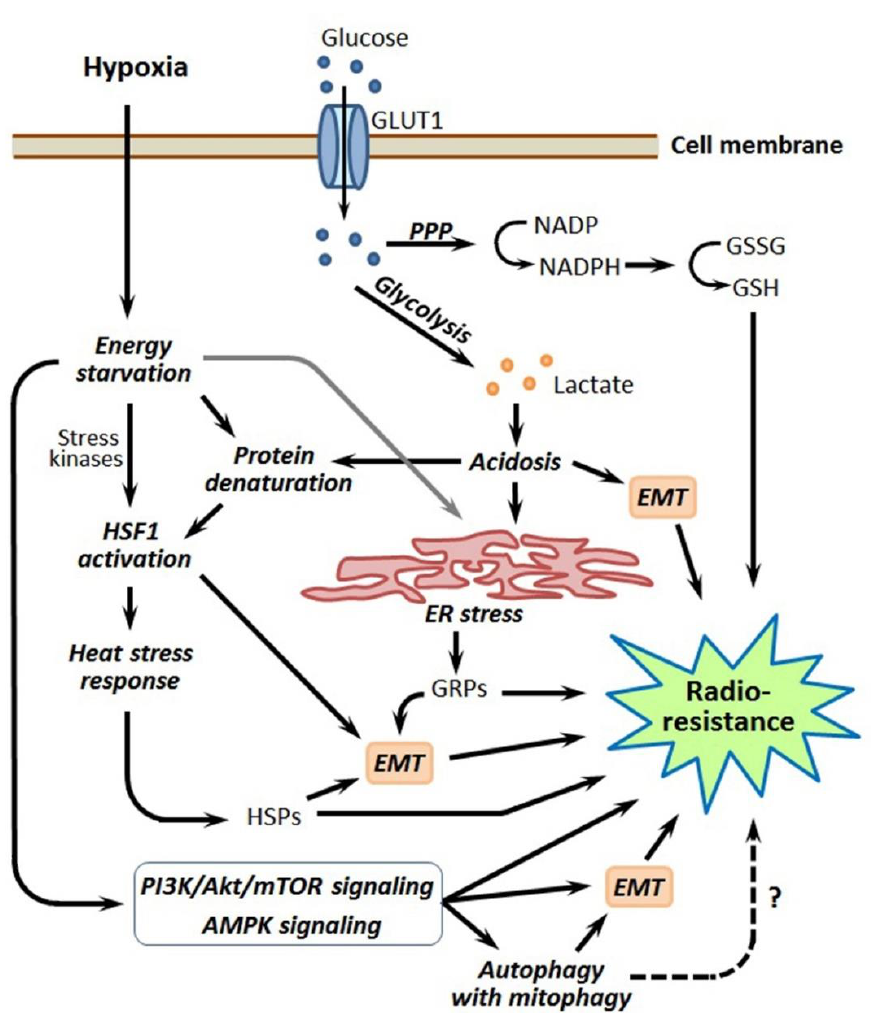
Figure 5. Simplified scheme that links hypoxia-induced energy metabolism reprogramming with other pathways, leading to the radioresistance of hypoxia-adapted cancer cells. Details are given in the text. Abbreviations: GLUT1—glucose transporter 1, PPP—pentose phosphate pathway, NADP and NADPH—nicotinamide adenine dinucleotide phosphate and its reduced form, GSSG and GSH—oxidized and reduced forms of glutathione, EMT—epithelial–mesenchymal transition, HSF1—heat shock factor 1, ER—endoplasmic reticulum, GRPs—glucose-regulated proteins, HSPs—heat shock proteins, PI3K—phospho-inositide 3-kinase, mTOR—mammalian target of rapamycin and AMPK—AMP-activated protein